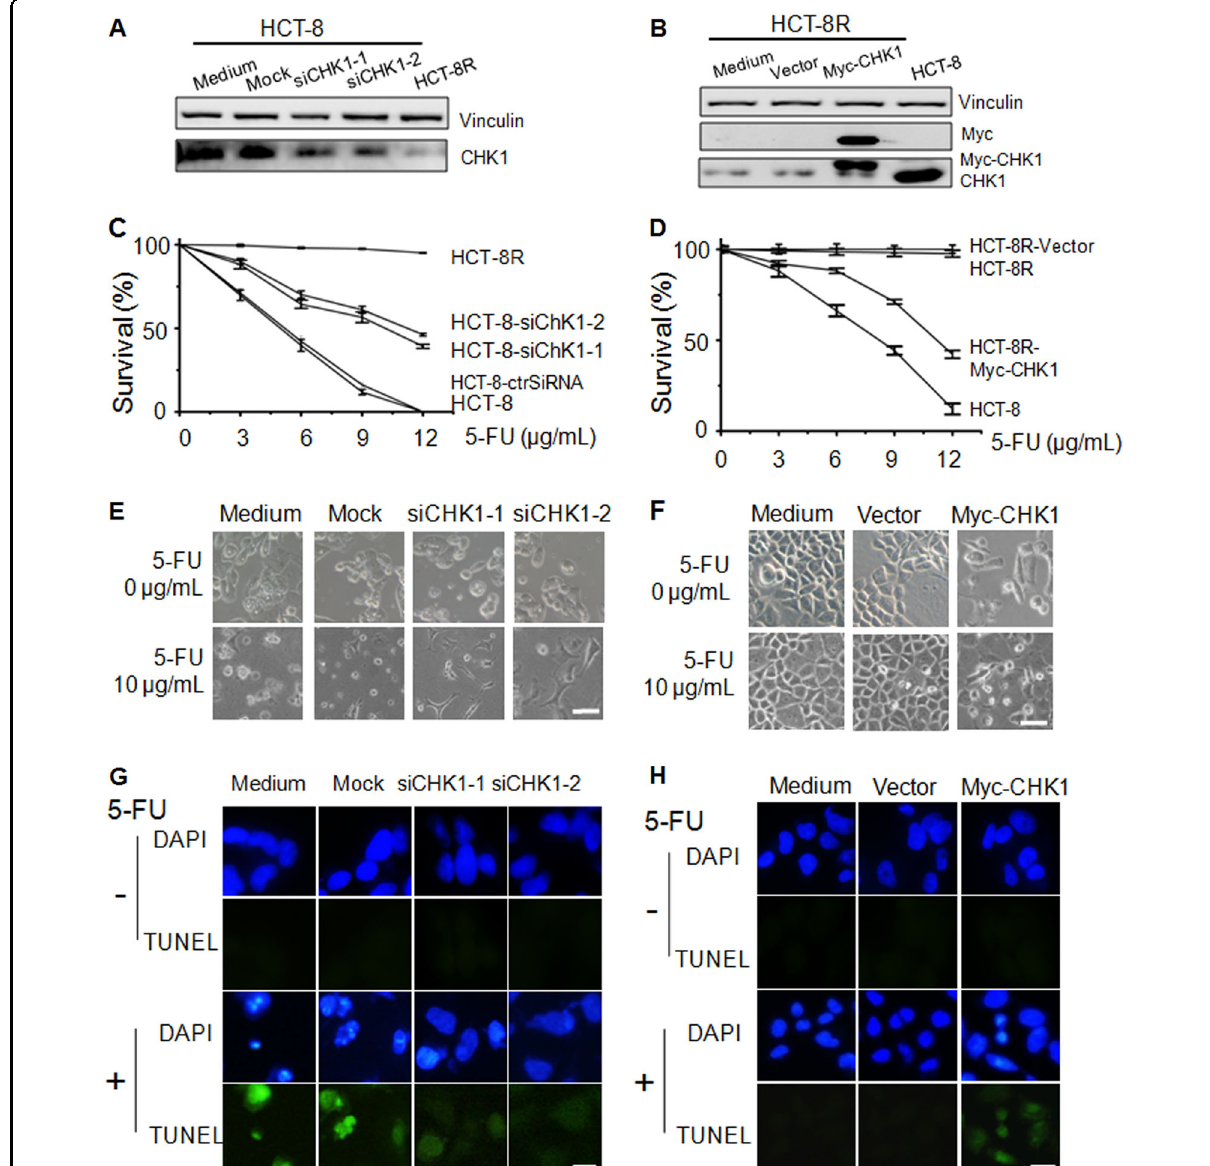
Fig. 3 Enhanced resistance to 5-FU is due to the suppressed checkpoint pathway. a The knockdown ef fi ciency of CHK1 was shown by immunoblot assay. b Overexpressed CHK1 expression was con fi rmed by immunoblotting assay. c The cell survival curve shows that the cell survival rate of the CHK1 knockdown HCT-8 cells with 10 µg/ml 5-FU was signi fi cantly higher than that of mock-transfected cells. d Overexpressed CHK1 expression decreased the cell survival rate in 10 µg/mL 5-FU-containing medium. e Cell morphology under a microscope. All cells transfected with CHK1 siRNA were treated with 10 µg/mL 5-FU for 48 h. Scale bar, 50 µm. f Cell morphology of CHK1-overexpressing HCT-8 cells and mock-treated cells (×400). Scale bar, 50 µm. g TUNEL assay shows the apoptotic cells induced by 5-FU treatment. Scale bar, 10 µm. h TUNEL assay shows the apoptotic cells induced by CHK1 overexpression. Scale bar, 10